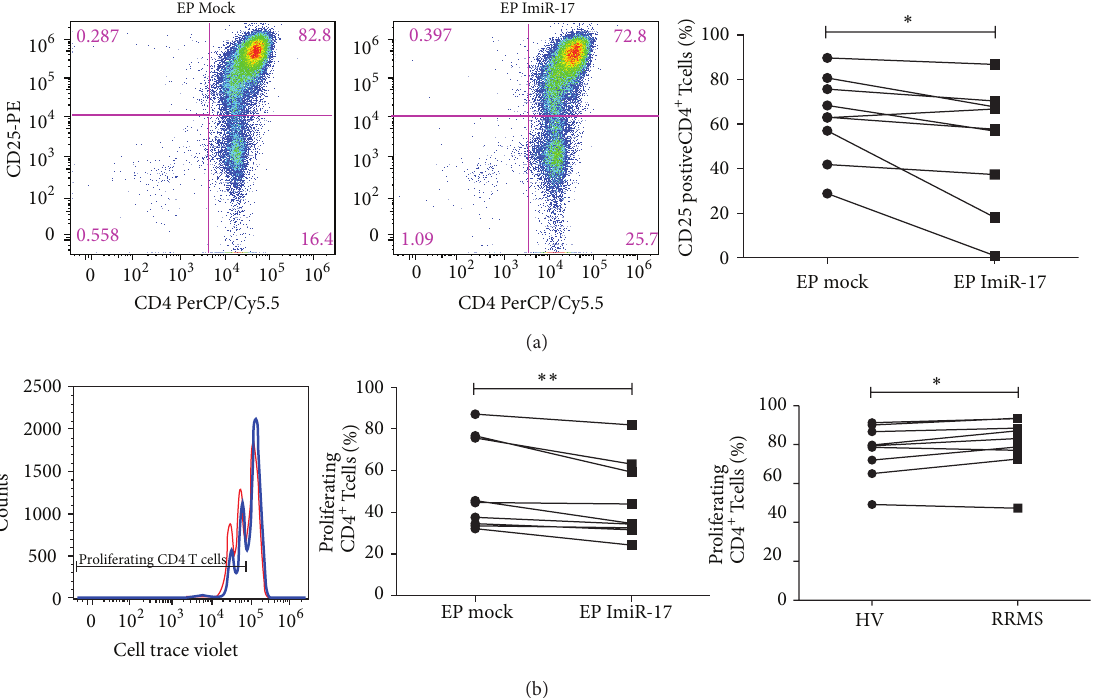
Figure 5: Flow cytometric analysis of CD4 + T cell activation and proliferation. (a) CD4 + T cell activation. (Left panel) Representative FACS dot plots of CD4 and CD25 surface expression in CD3/CD28 (1: 10 bead/cell ratio) stimulated CD4 + T cells from a HV following electroporation (EP) with a miR-17 synthetic inhibitor (ImiR-17) or vehicle control (mock). The percentage of cells contained within each subset is indicated. (Right panel) Frequency of CD4 + CD25 + T cells in 9 independent miRNA-17 inhibition experiments. (b) CD4 + T cell proliferation. CD4 + T cells were labeled with cell trace violet proliferation dye and then placed in culture in the presence of CD3/CD28 stimulus for 72H and examined by flow cytometry. (Left panel) Representative histogram plot of cell proliferation in CD3/CD28 (1:10 bead/cell ratio) stimulated CD4 + T cells from a HV following electroporation (EP) with a miR-17 synthetic inhibitor (blue line) or vehicle control (mock) (red line). Proliferating CD4 + T cells are depicted. (Middle panel) Frequency of proliferating CD4 + T cells in 9 independent miRNA-17inhibitionexperiments.(Rightpanel)FrequencyofproliferatingCD4 + TcellsfromHVsversusRRMSuntreatedpatientsfollowing CD3/CD28 stimulation (1: 1 bead/cell ratio) ( 𝑛 = 9 ). Paired 𝑡 -test was used. ∗∗ 𝑃 < 0.01 ; ∗ 𝑃 < 0.05